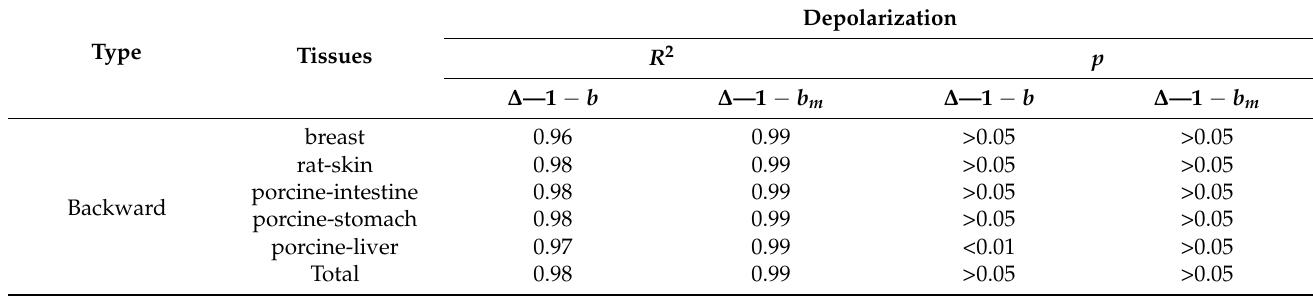
Table 9. Correlation and statistical analysis comparison results between backward measured MMT and MMPD depolariza- tion parameters for each kind of bulk tissue